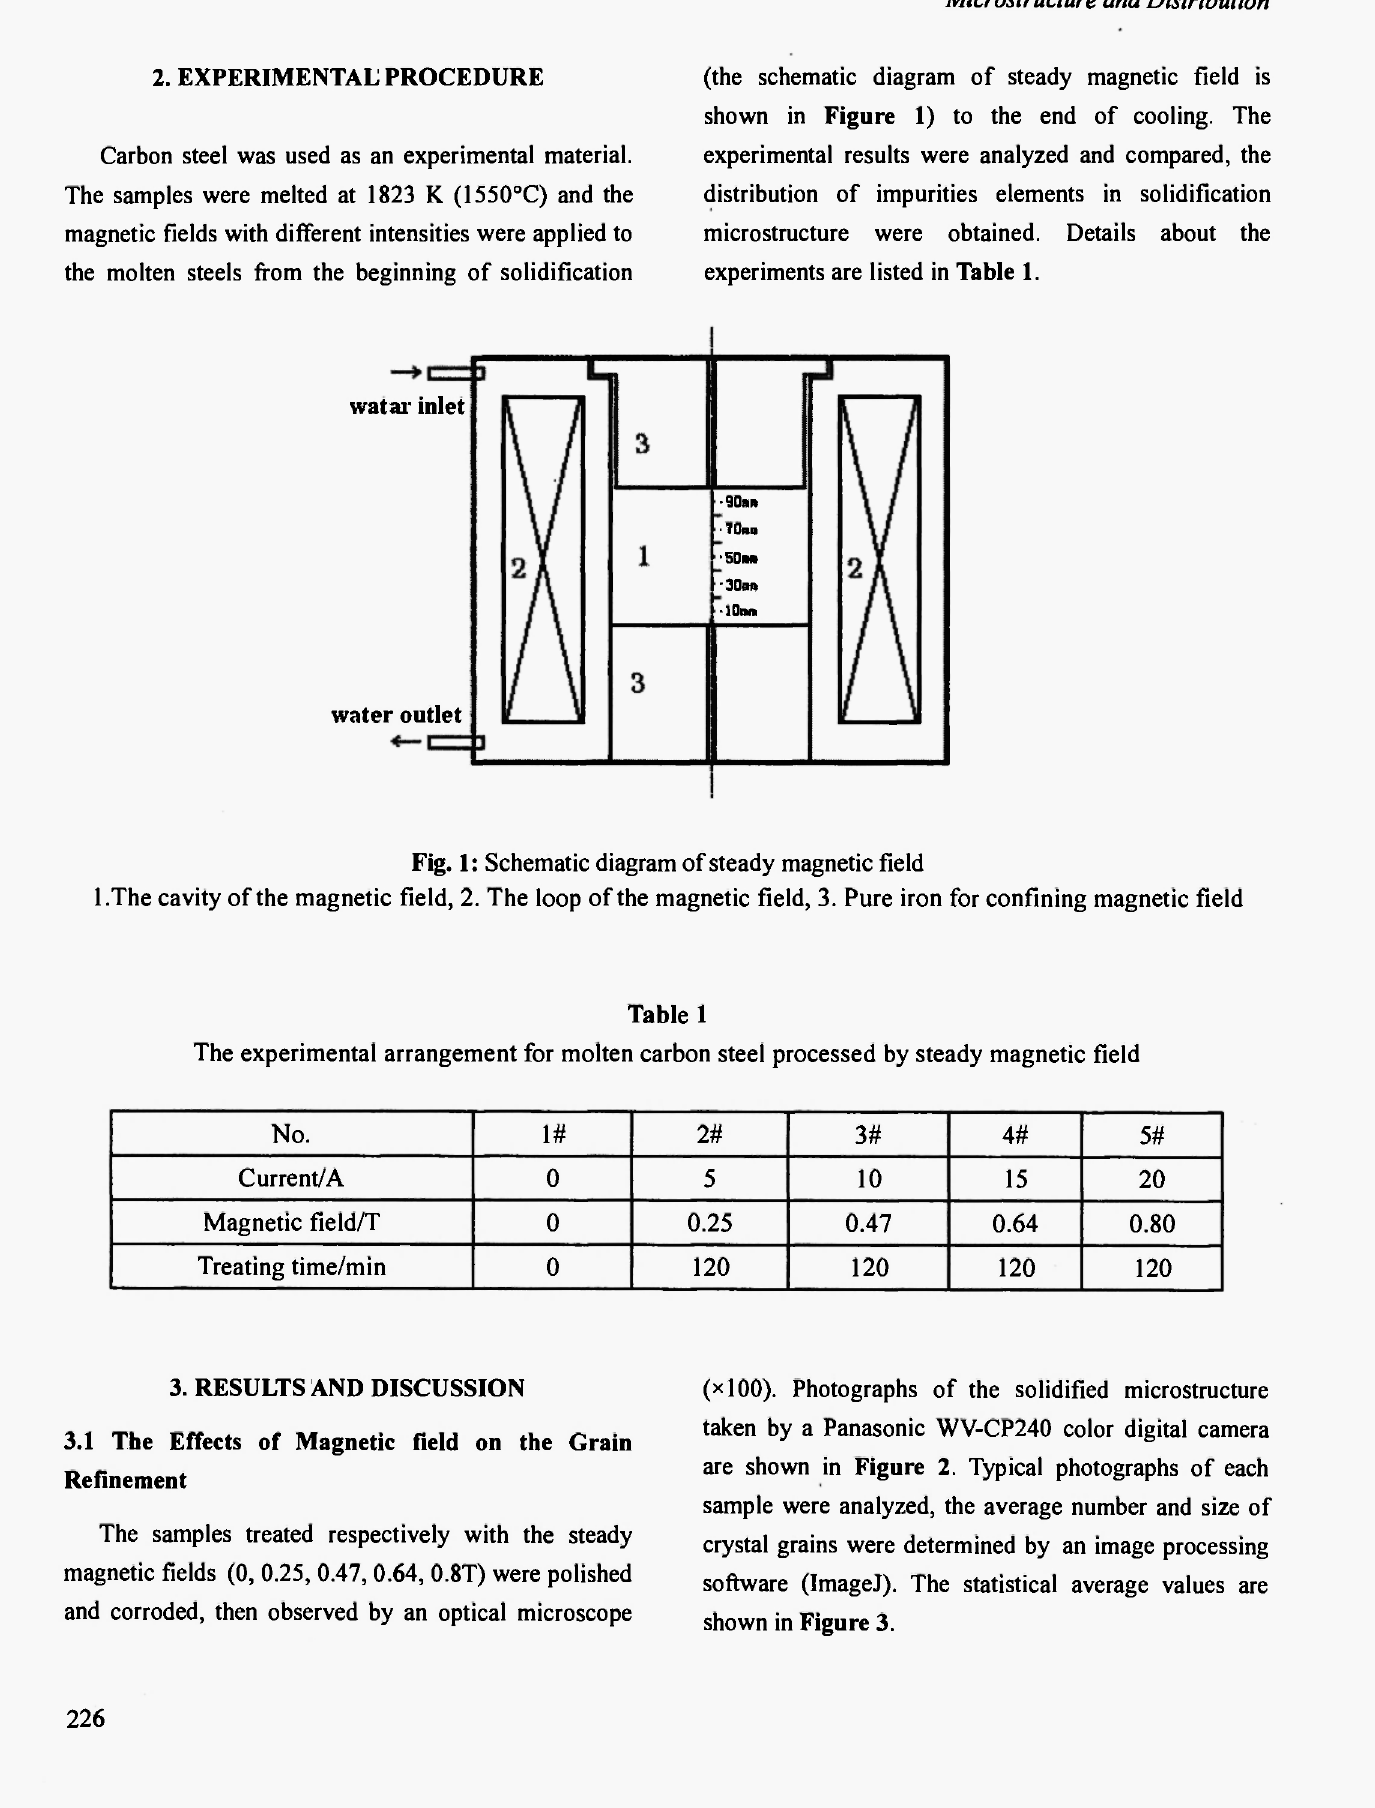
(χ 100). Photographs of the solidified microstructure are shown in Figure 2. Typical photographs of each sample were analyzed, the average number and size of